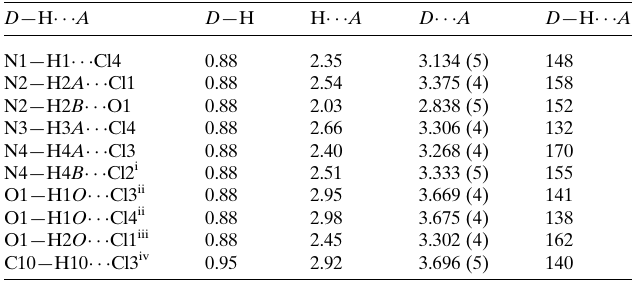
Table 5 Hydrogen-bond geometry (A˚ , (cid:3) ) for (V).